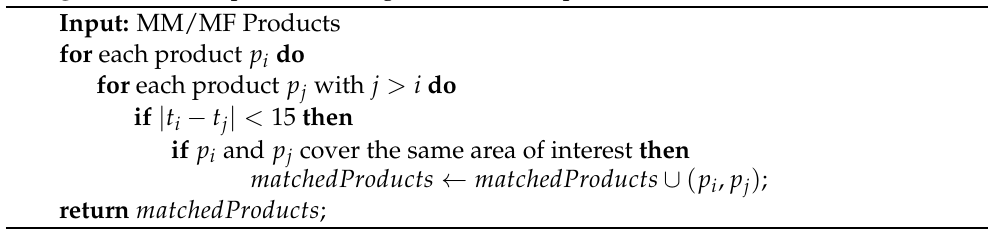
Algorithm 1: Footprint matching MM/MF SAR products.